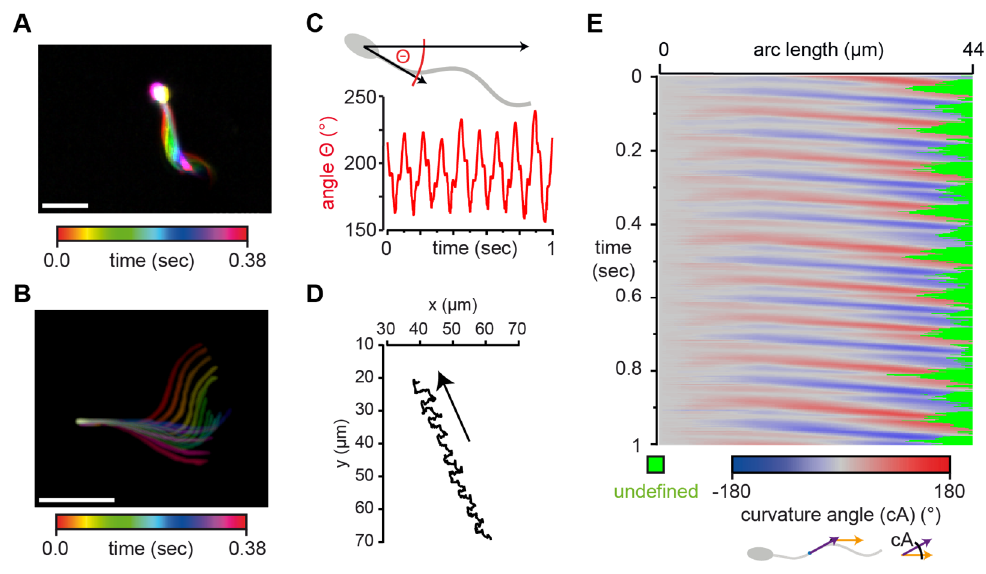
Figure 5. SpermQ reveals the beat pattern of a freely-swimming human sperm. SpermQ analysis of a human sperm, freely-swimming in a shallow observation chamber (depth 300 µm); ( A ) projection of the raw image and ( B ) the trace after orientation to the head midpiece axis, each representing one beat cycle; ( C ) SpermQ-analysis reveals that the head orientation angle Θ stably oscillates with the primary frequency of 9 Hz (rolling frequency of the sperm) and the secondary frequency of 27 Hz (beat frequency) (center of mass (COM) of frequency spectrum: 21.2 Hz); ( D ) trajectory of the sperm’s head position; ( E ) Kymograph of the determined curvature angle (cA). Scale bars: 20 µm.